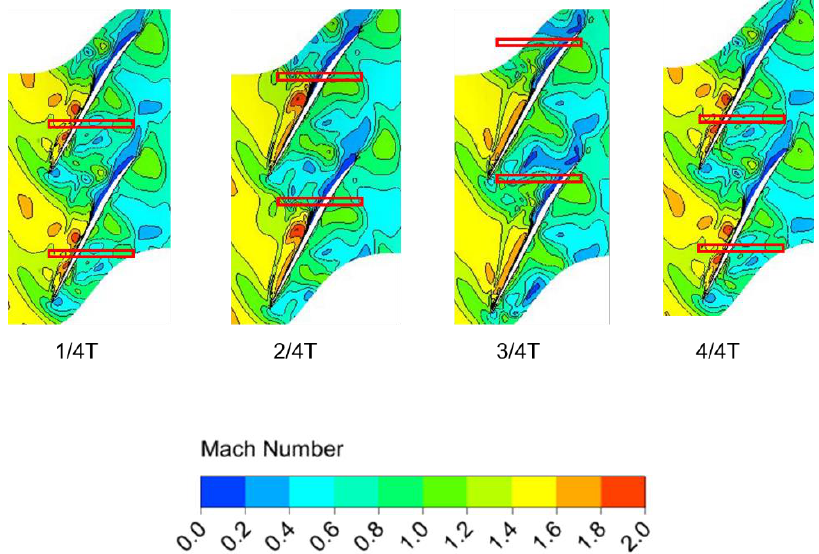
Figure 13. Mach number contours at 99% span in an unsteady period for 10% axial slots.